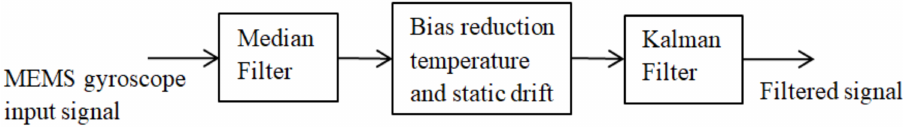
Figure 12. Structure of the compensation method with